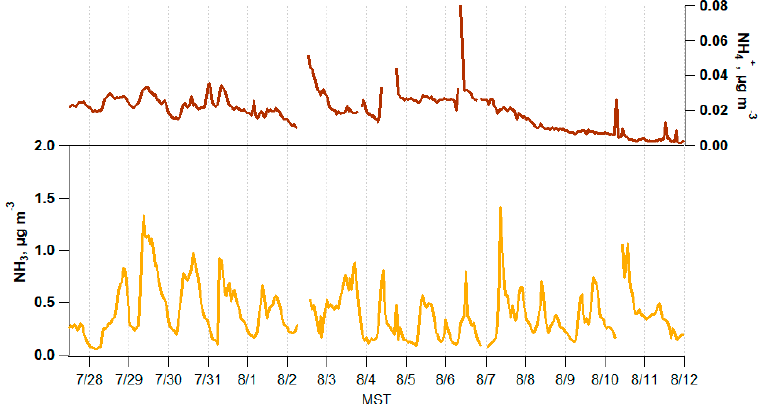
Figure 2. Ambient concentrations particulate NH 4+ (top) and ambient NH 3 (bottom) observed in MEFO by the AIM-IC from 27 July to 13 August 2015, in which date and time are presented in Mountain Standard Time (MST).